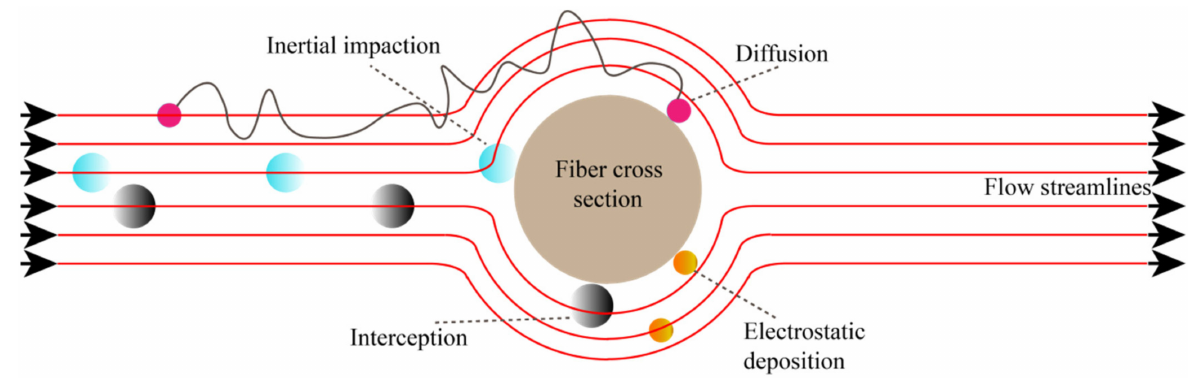
Figure 8. Filtration mechanism of membranes [10].